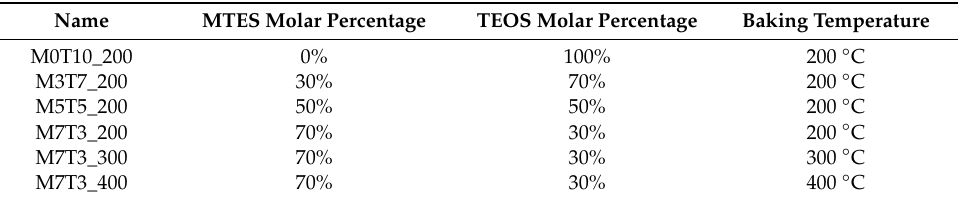
Table 1. List of the studied